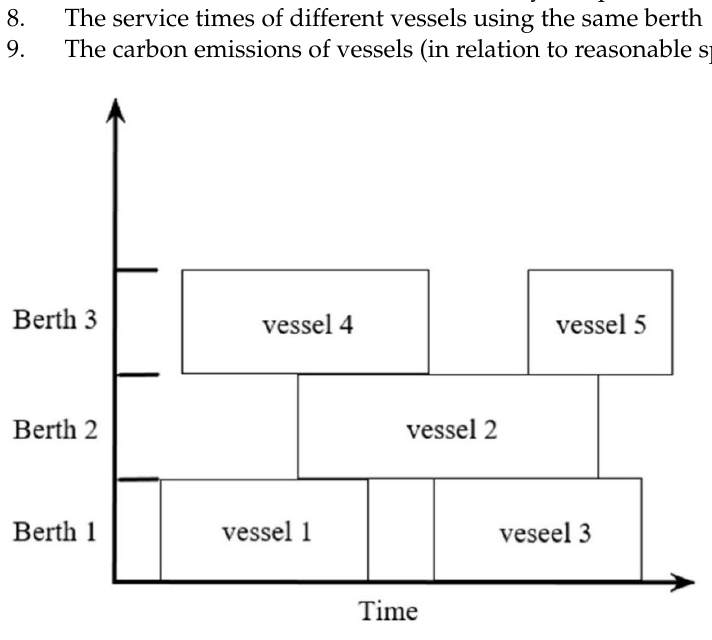
Figure 3. Two-dimensional Gantt chart of berth